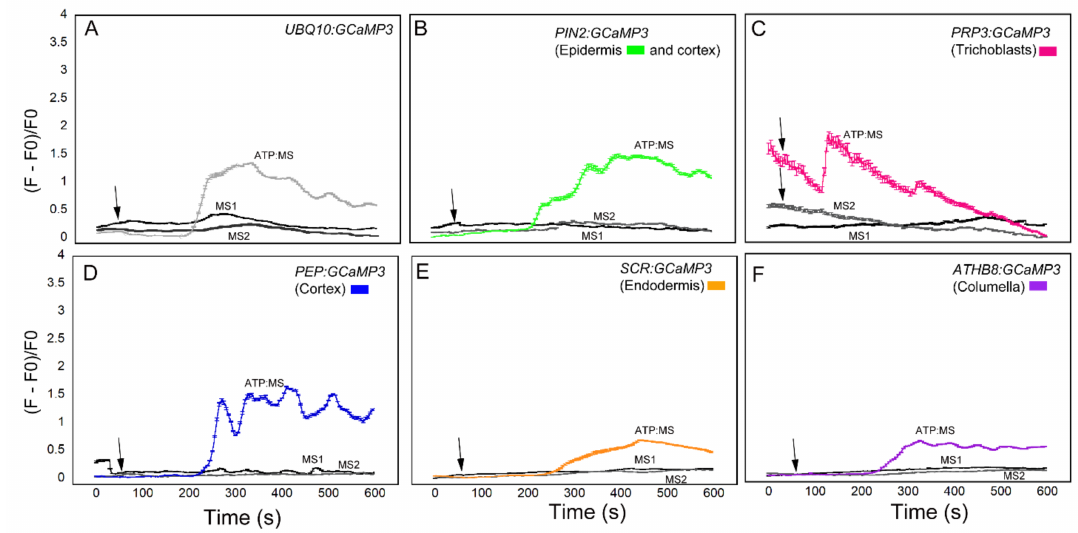
Figure 7. ATP-triggered [Ca 2 + ] cyt responses in cell type-specific GCaMP3 lines planted on fresh